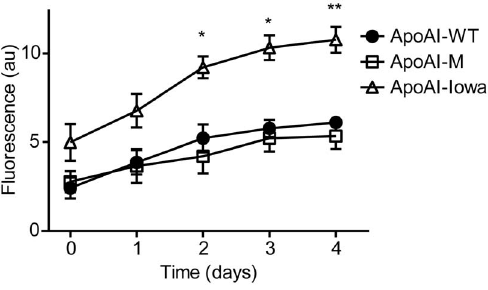
Figure 4. The amyloidophilic dye ThT does not bind to the apoAI-Milano protein. The binding of thioflavin T (ThT) to apoAI-M was assessed and compared to apoAI-WT. No significant binding of ThT to apoAI-WT and apoAI-M was observed over a four-week period of incubation at 37 u C. This result is in contrast to apoAI-Iowa protein, known for its propensity to form cross-beta amyloids, which had higher ThT binding than both apoAI-WT and apoAI-M, and thus higher beta sheet content. *p , 0.05, n=3; **p , 0.01, n=3.